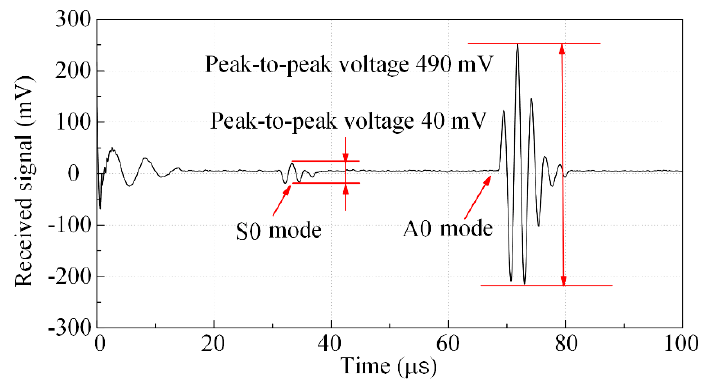
Figure 12. Received Lamb at the distance h = 0 mm.